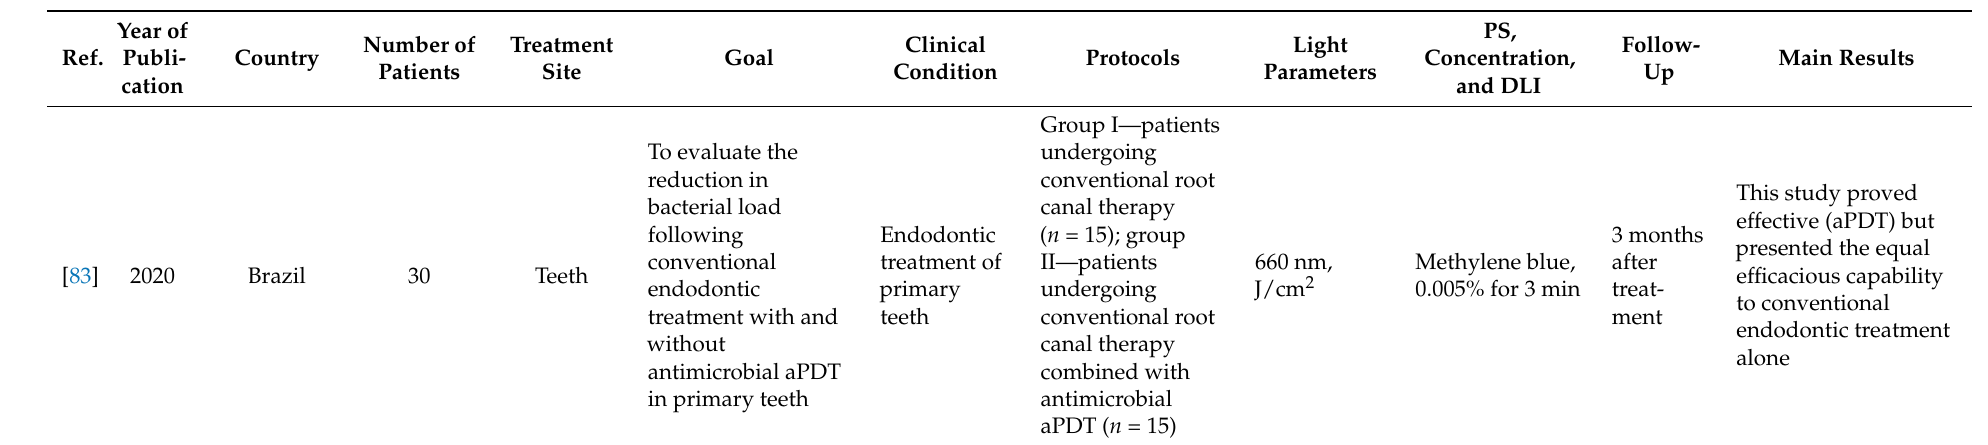
Table 5. Randomized clinical trials that evaluated aPDT for oral decontamination.